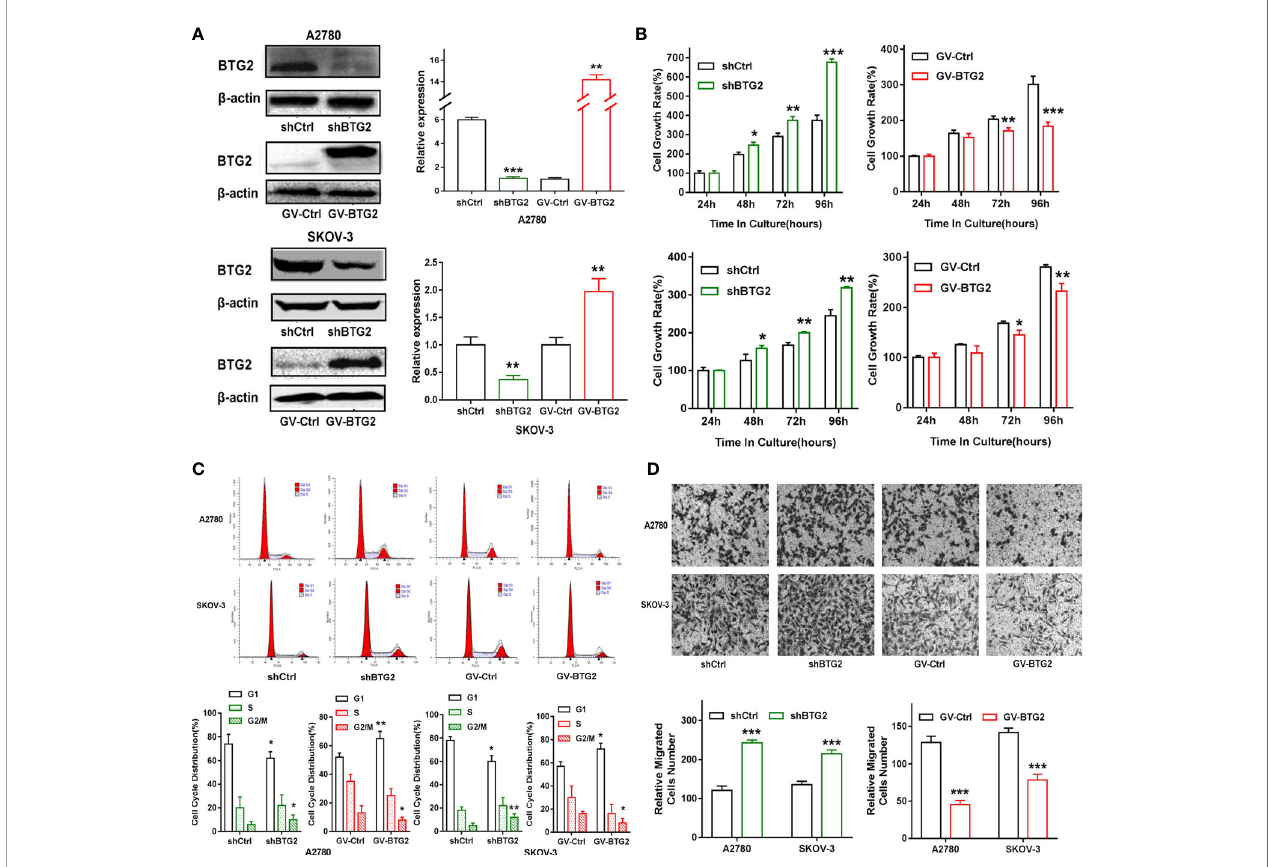
FIGURE 4 | BTG2 inhibited ovarian cancer cell proliferation, blocked cell cycle progression and impacts cell migration. (A) Knockdown and Over-expression ef fi ciencies were determined by Western blot in A2780 and SKOV3 cells. (B) Knockdown and Over-expression of BTG2 signi fi cantly reduced the proliferative capacities of A2780 and SKOV3 cells, as determined by MTT assay. (C) Cell cycle distribution was analyzed using fl ow cytometry and the percentage of G1 phase was signi fi cantly decreased in shBTG2 group compared to negative control group and increased in GV-BTG2 group compared to negative control group in both A2780 and SKOV3 cells. (D) The images represented cell migration into the underside of transwell membrane under microscope at 100×magnifcation fi eld. A2780 and SKOV3 cells that crossed the transwell chamber of each group was counted and averaged. The experiments were repeated three times with three replicates each. *p < 0.05, **p < 0.01, ***p <